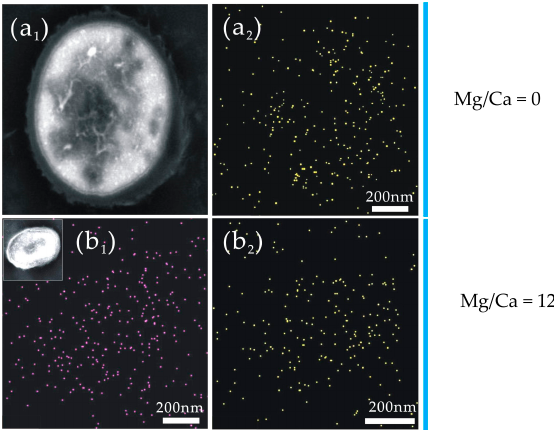
Figure 9. Bacterial ultra-thin slices analyzed by scanning transmission electron microscopy (STEM). Yellow and purple indicates Ca and Mg, respectively. ( a 1 ) bacterial ultra-thin slices analyzed by STEM; ( a 2 ) the distribution of Ca in/on the cell shown in (a 1 ); ( b 1 ) the distribution of Ca in/on the cell shown in the inset; ( b 2 ) the distribution of Mg in/on the cell shown in the inset of (b 1 ).